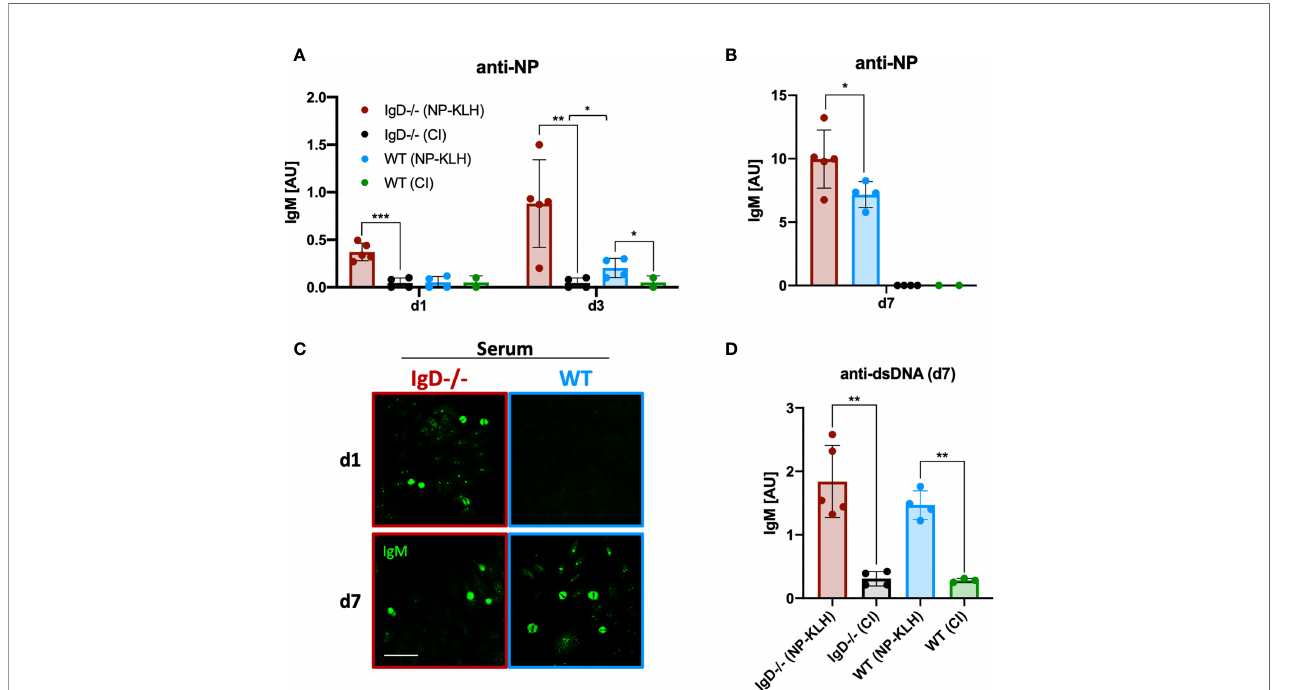
FIGURE 2 | IgD-de fi cient mice mount robust polyreactive IgM responses one day after immunization. (A, B) Serum immunoglobulin titers of NP-KLH (IgD-de fi cient n=5, WT n=4) and CpG ODN1826 (control immunization: CI, IgD-de fi cient n=4, WT n=2) injected mice measured by ELISA. NP-reactive IgM of day 1 and 3 (A) and day 7 (B) . Mean,± SD,statisticalsigni fi cance was calculated byusing Kruskal-Wallis-test. (C) Serum immunoglobulinsreactive to self-molecules (DNA/RNA) of NP-KLH and CI injected IgD-de fi cient and WTmice tested via HEp2slides. Fluorescence microscopy images are representative for three independent experiments. Scalebar:10 µm. (D) Serum immunoglobulin titersof NP-KLH (IgD-de fi cient n=5, WT n=4) andCI injected (IgD-de fi cient n=4, WTn=2)mice measured byELISA. dsDNA-reactive IgM of day 7 post immunization. Students t-tests with Welch ’ s correction were used to compare two groupswithin one experiment. Mean, ± SD.*P < 0.05, **P <